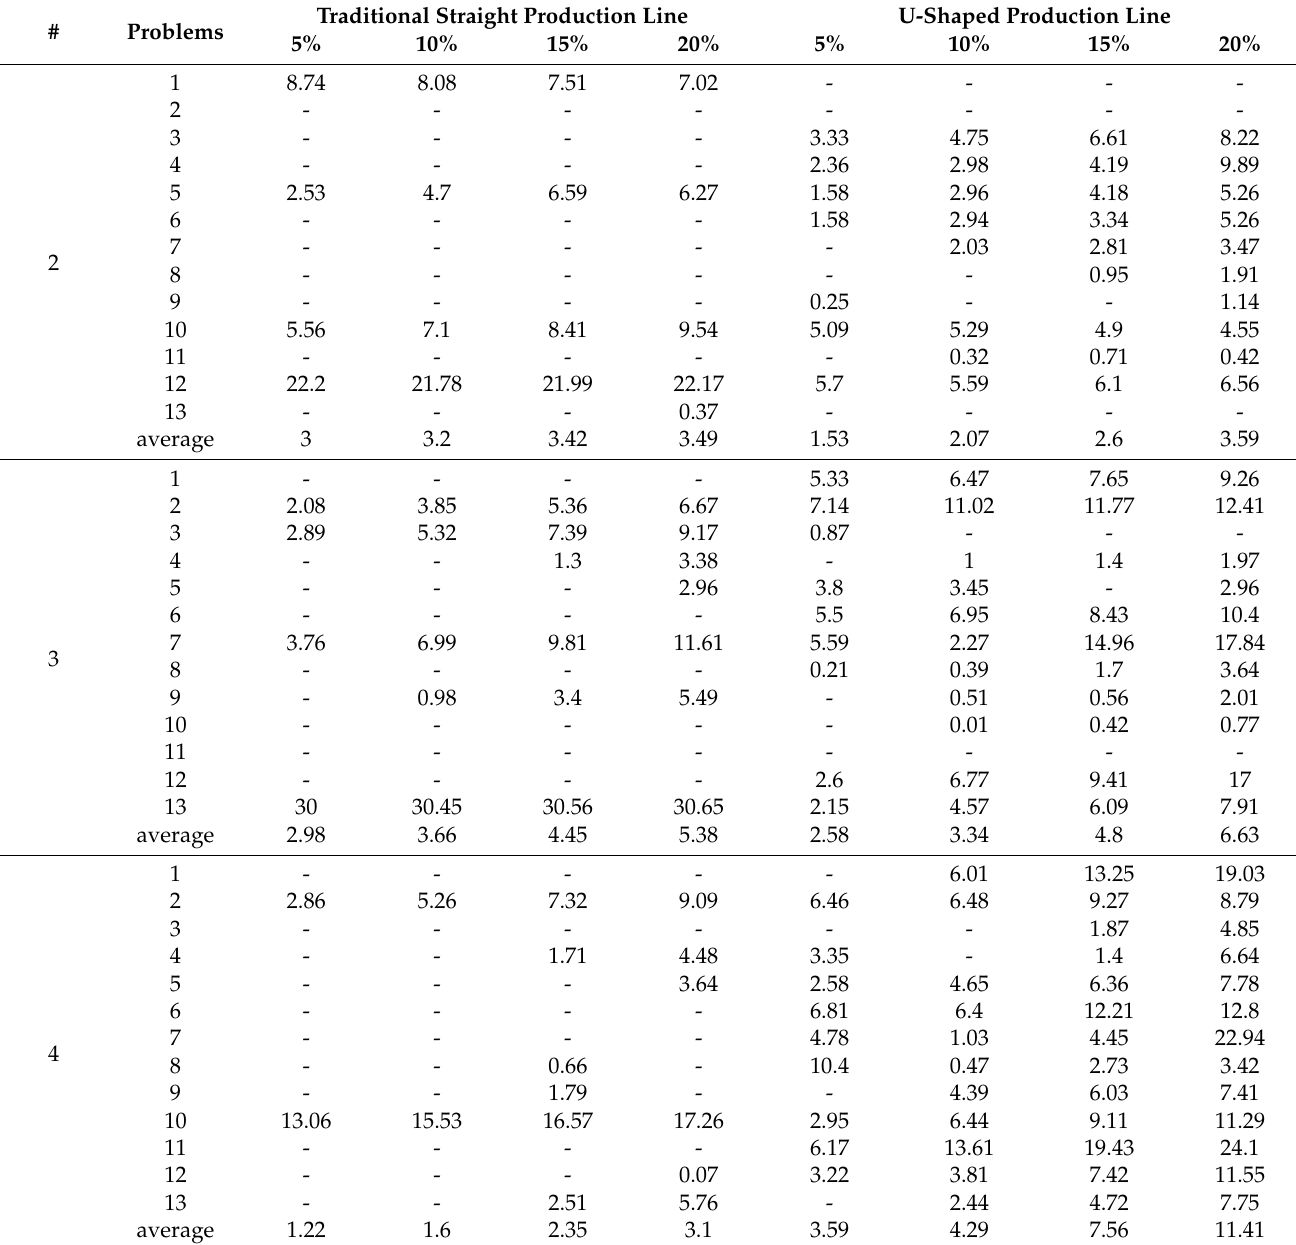
Table 4. Improvement when considering walking times